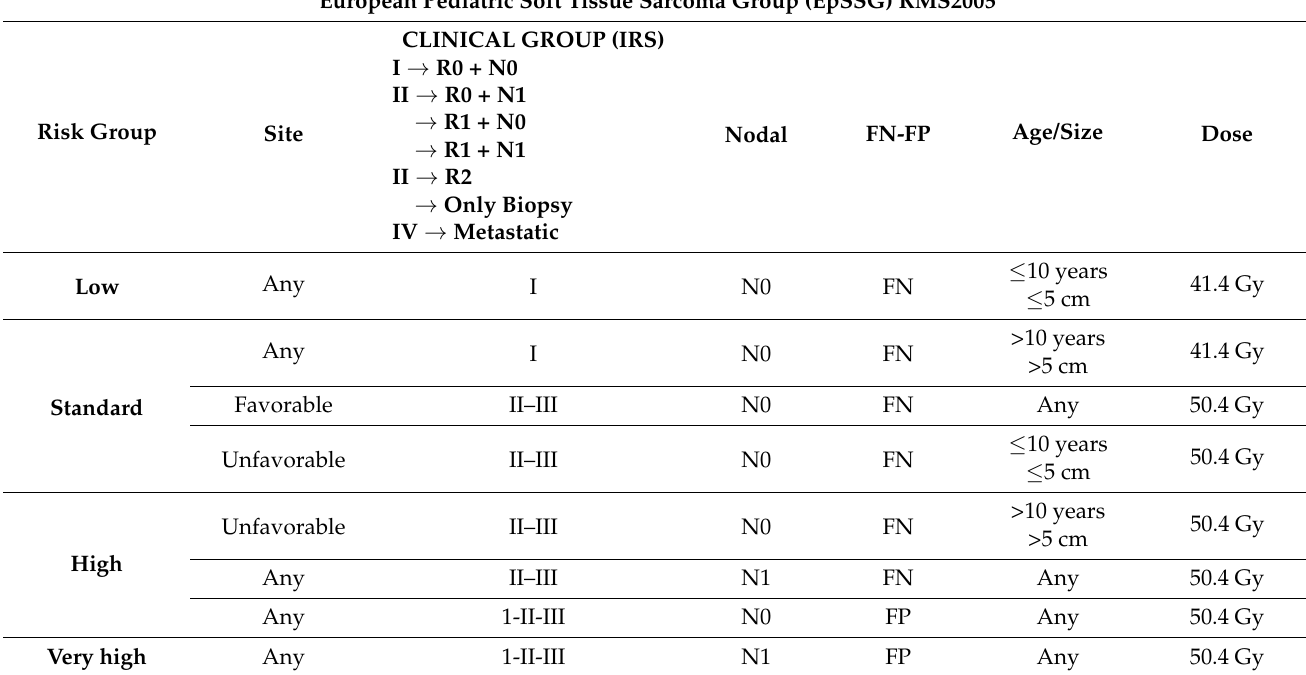
Table 3. RMS prognostic groups based on European Pediatric Soft Tissue Sarcoma Group (EpSSG)